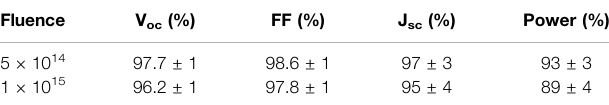
TABLE1| TheparametersofGalnAsNsolarcellafter1MeVelectronirradiation[51]. Fluence V oc (%) FF (%) J sc (%) Power